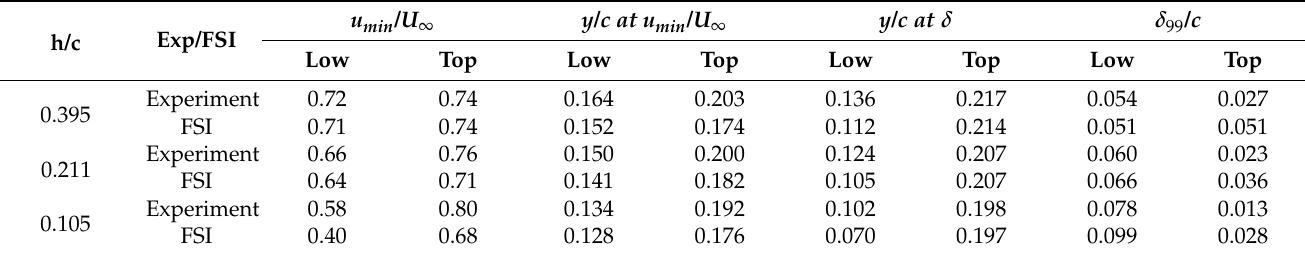
Figure 15. Wake profiles at various ride heights at x/c = 1.066. Table 6. Information on wake profiles for various ride heights at x/c = 1.066.